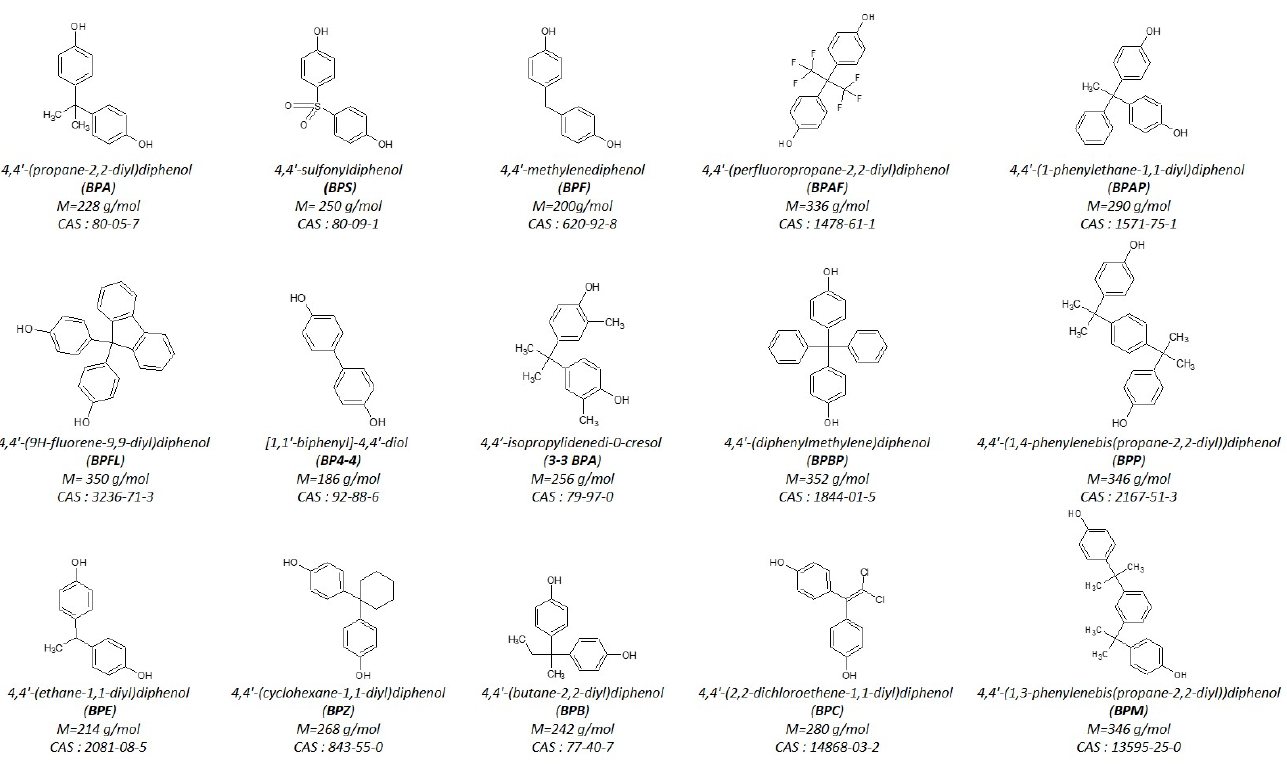
Figure 1. Molecular structure of the fifteen bisphenols with their respective name, abbreviation, molecular weight, and CAS number.